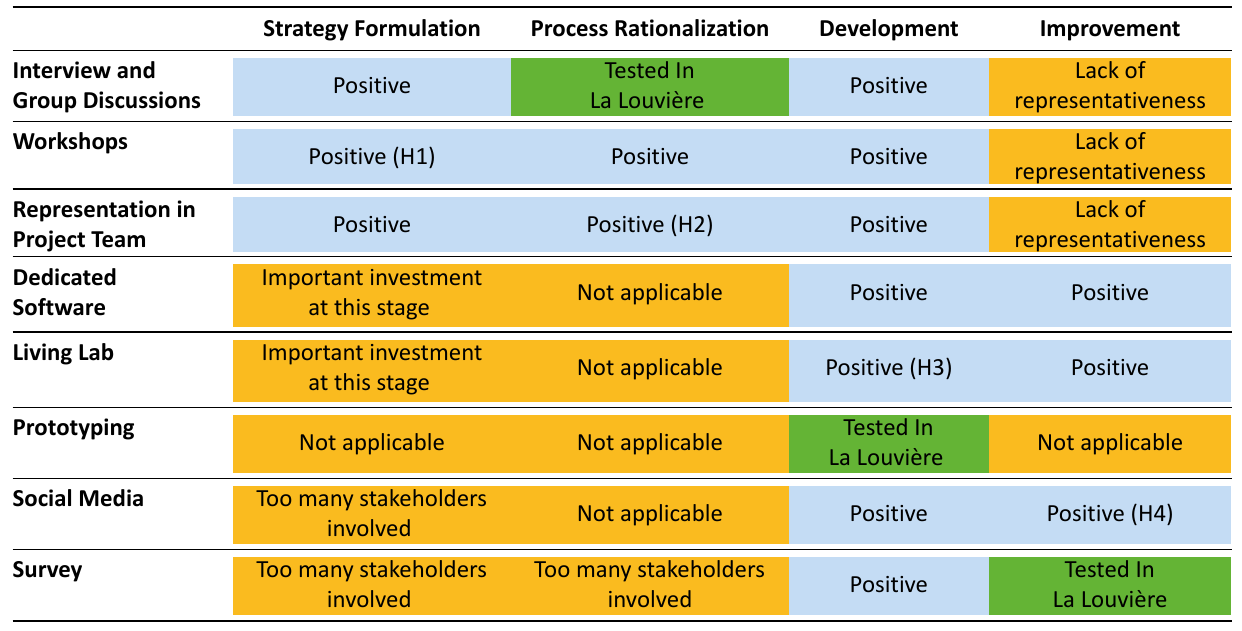
Table 3. Participation methods